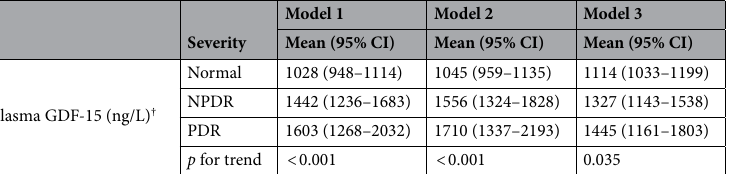
Table 2. Average plasma GDF-15 levels according to diabetic retinopathy severity in patients with type 2 DM. The data are shown as means (95% CI). † Values were log-transformed prior to analyses. Model 1: adjusted by sex and age. Model 2: model 1 + adjusted by BMI, hs-CRP † , hyperlipidemia, and hypertension. Model 3: model 2 + adjusted by plus HbA 1c , diabetes duration † , AER † , eGFR, and use of insulin and OHAs. AER, albumin excretion rate; BMI, body mass index; CI, confidence interval; DM, diabetes mellitus; eGFR, estimated glomerular filtration rate; GDF-15, growth differentiation factor-15; HbA 1c , glycated hemoglobin; hs-CRP, high-sensitivity C-reactive protein; OHAs, oral hypoglycemic